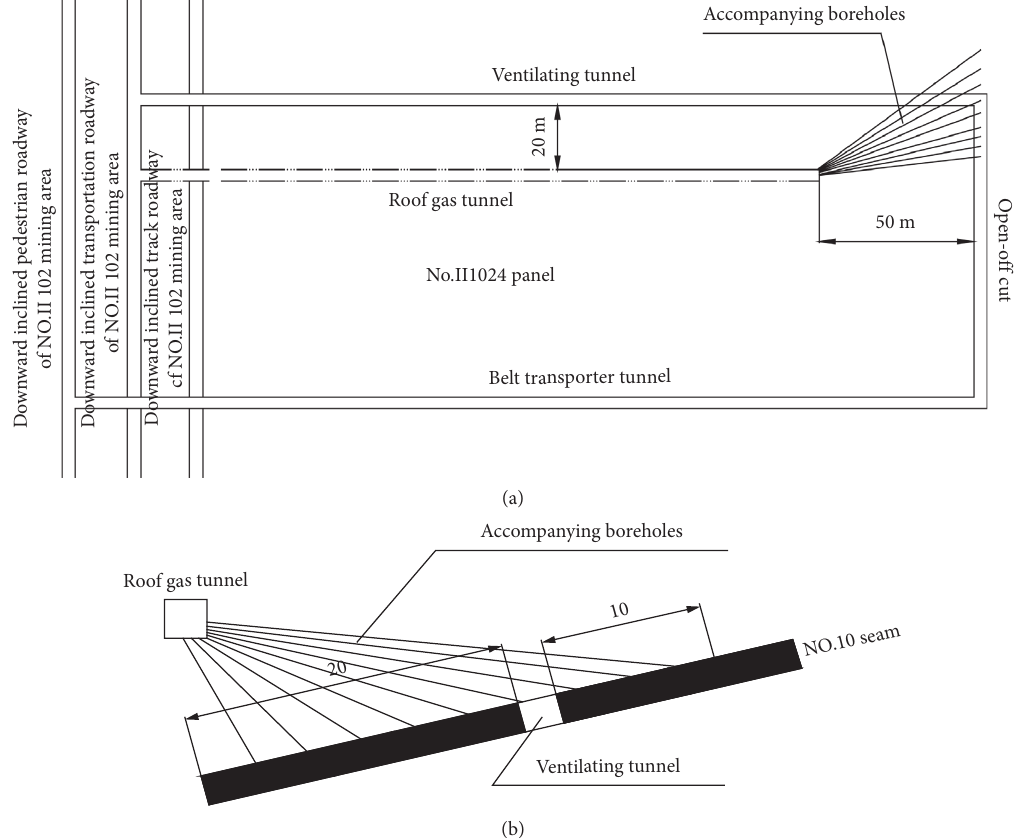
Figure 11: Roof gas drainage roadway and accompanying boreholes in No. 2 1024 panel: (a) plan view; (b) vertical cross